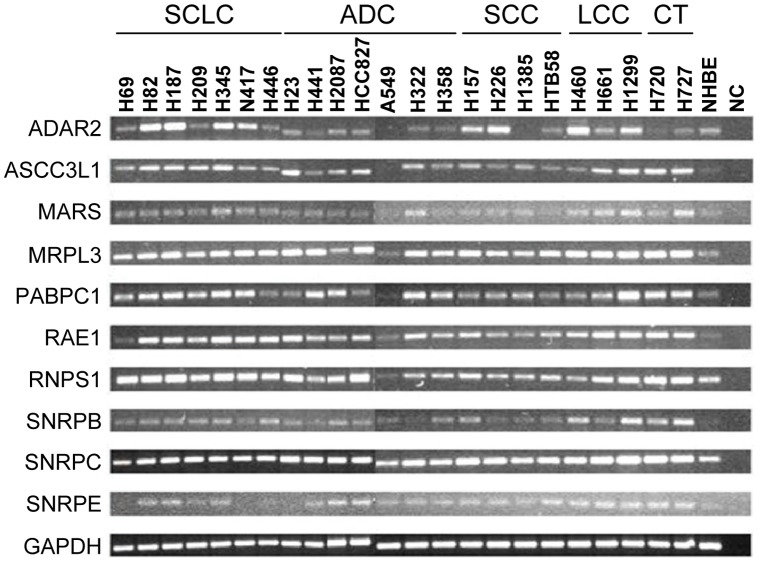
PCR expression analysis of RNA metabolism-related genes.Expression levels were determined in lung cancer cell lines and normal human bronchial epithelial (NHBE) cells. GAPDH was used as control gene. SCLC: small cell lung cancer; ADC: adenocarcinoma; SCC: squamous cell carcinoma; LCC: large cell carcinoma; CT: carcinoid tumor; NC: negative control (water).